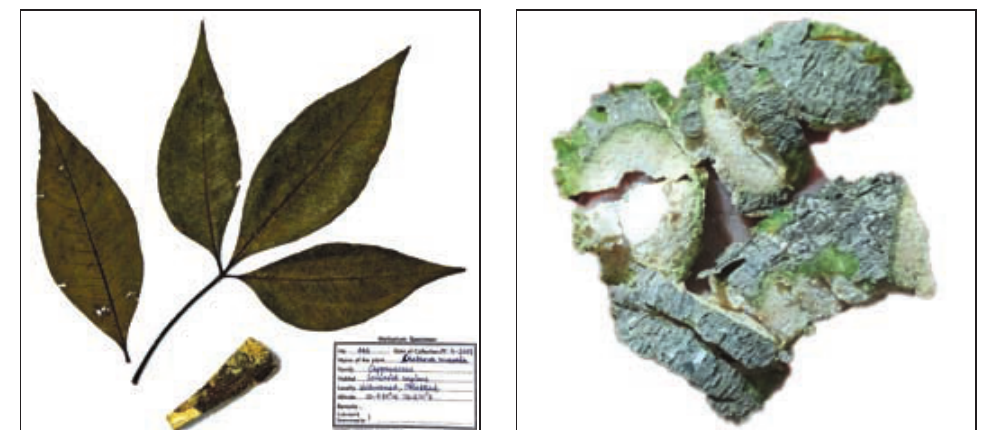
Fig. 2. Bark of Crataeva nurvala Buch-Ham.